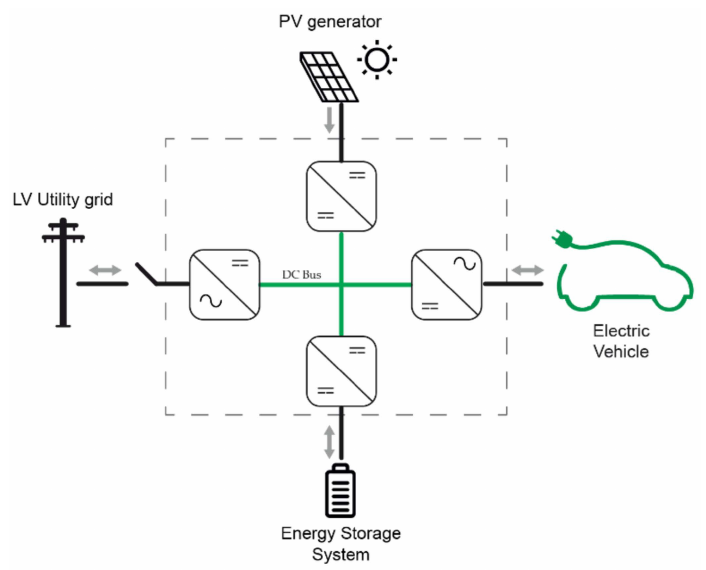
Figure 13. Possible configuration of a charging